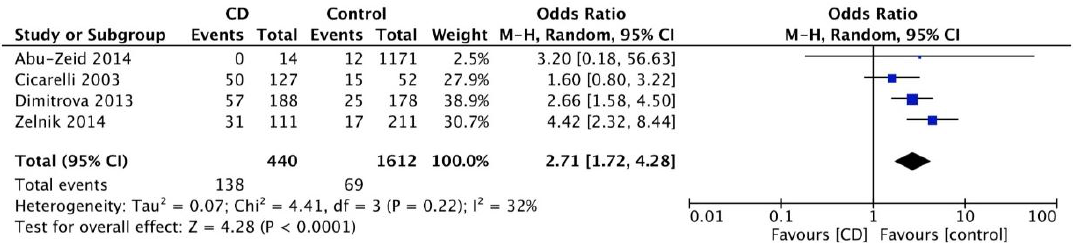
Figure 3. Meta-analysis results as illustrated in the forest plot regarding the odds of having headache in adults with coeliac disease compared to controls.